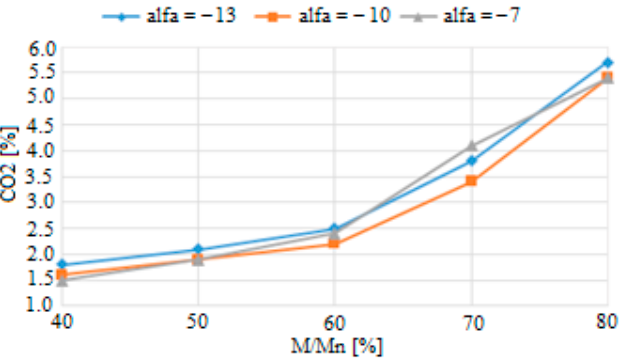
Figure 8. CO 2 content in exhaust as a function of the engine load and three different advance angles of fuel injection, for a constant rotational speed n = 220 rpm.